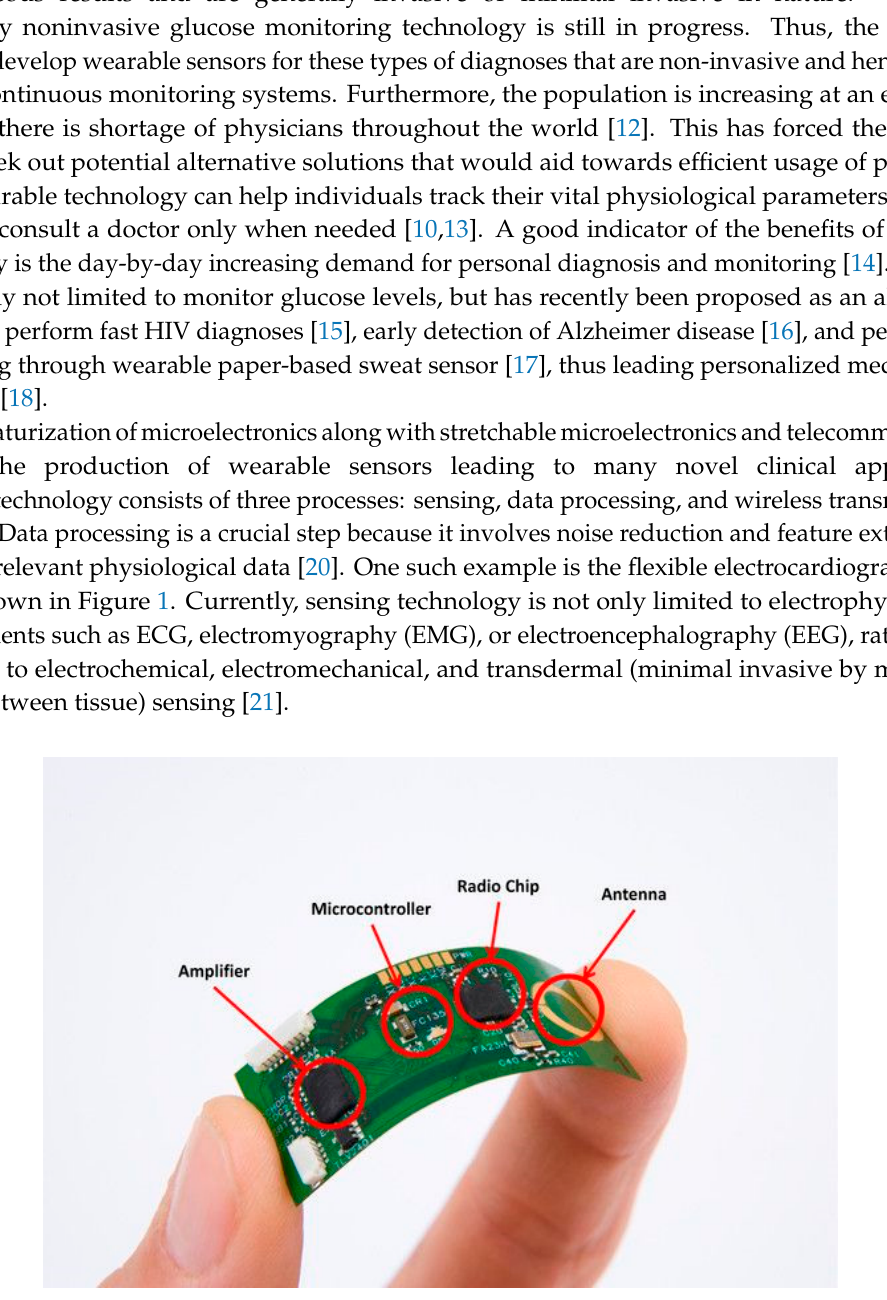
Figure 1. Flexible electrocardiograph (ECG) sensor with its components (courtesy of IMEC, the Netherlands).